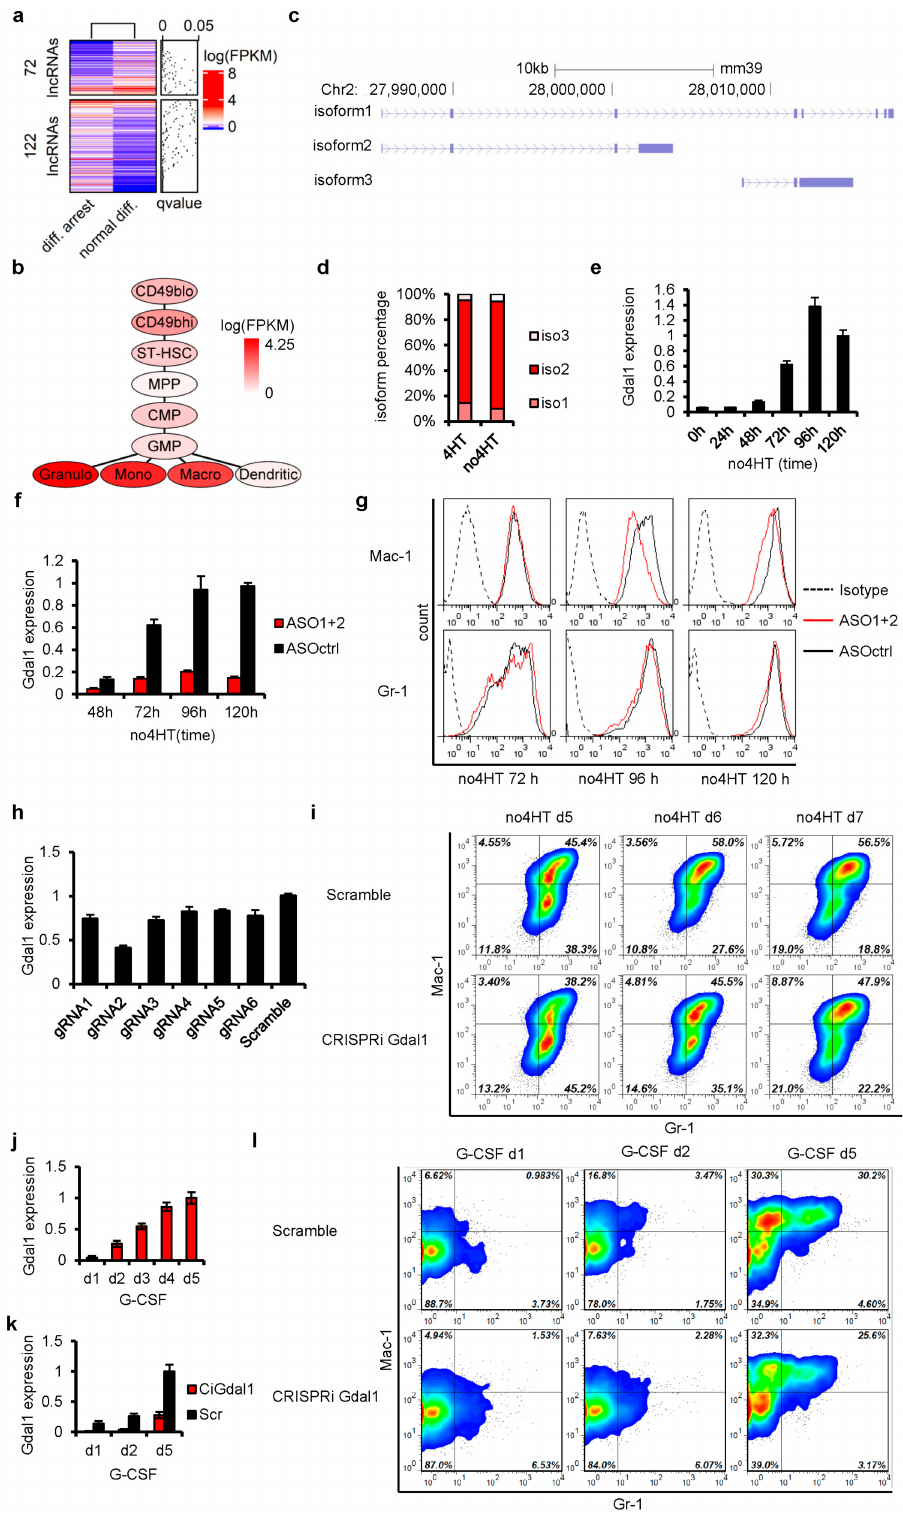
Figure 2. Gdal1 was required for granulocytic differentiation. ( a ) The 72 lncRNAs and 122 lncRNAs enriched in differentiating and differentiation arrest CSH3 cells, respectively, were shown in heat-map. ( b ) Expression dynamics of Gdal1 during myeloid differentiation. CD49blo and CD49bhi stand